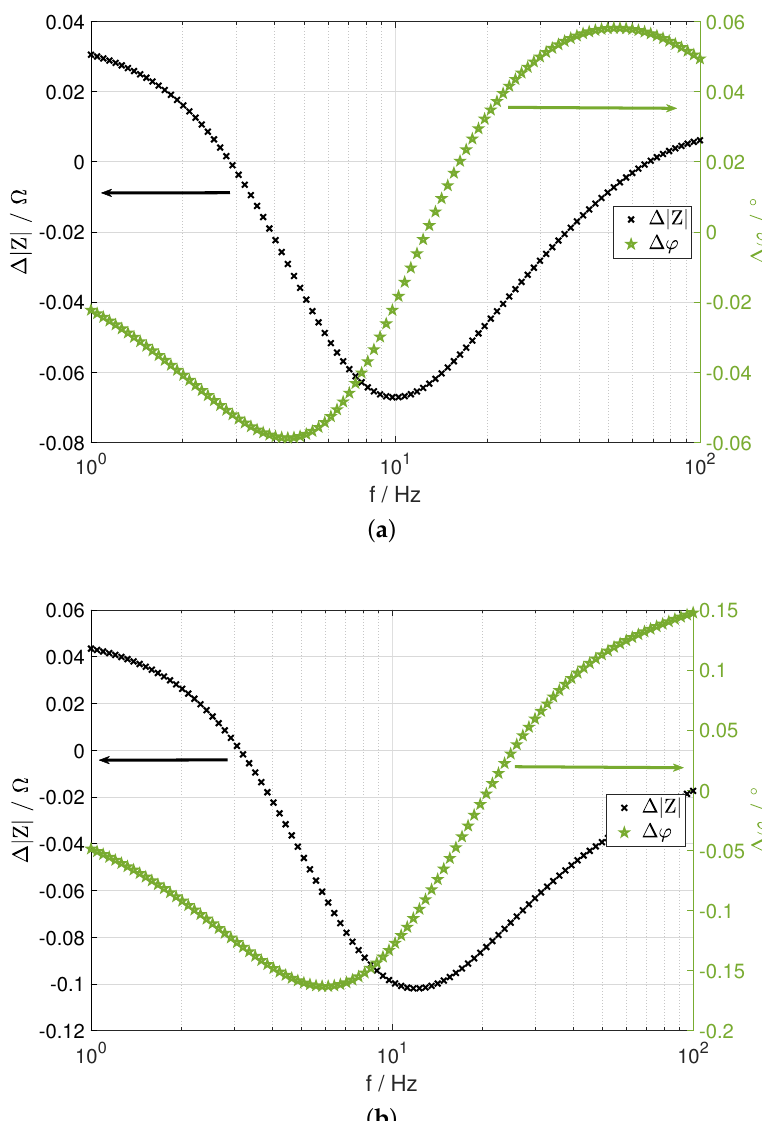
Figure 9. Differences between Meas 1 and Meas 2 for the impedance (black (cid:54) , calculated with Equation (1)) and the phase angle (green (cid:72) , calculated with Equation (2)) with a temperature gradient from ≈ 54.0–59.5 ◦ C. ( a ) Cell I. ( b ) Cell